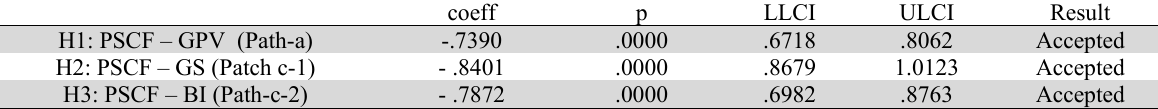
Effect of PSCF on Guests’ Perceived Value, Guests’ satisfaction and Behavioral Intentions (H1, H2 & 3) coeff p